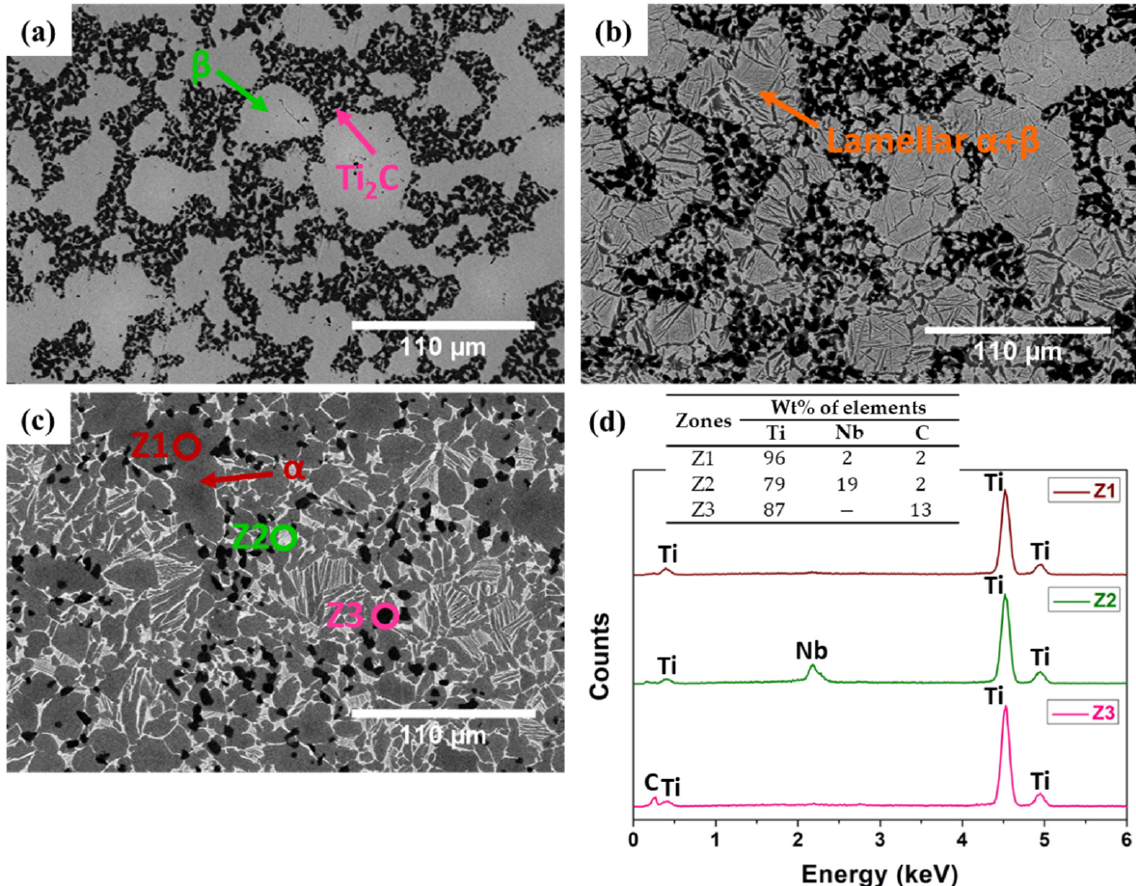
Figure 2. Microstructural analysis performed by SEM (BSE mode): ( a ) Ti+20NbC; ( b ) Ti+12.5NbC; ( c ) Ti+5NbC; and ( d ) EDS spectra of the zones represented in ( c ).